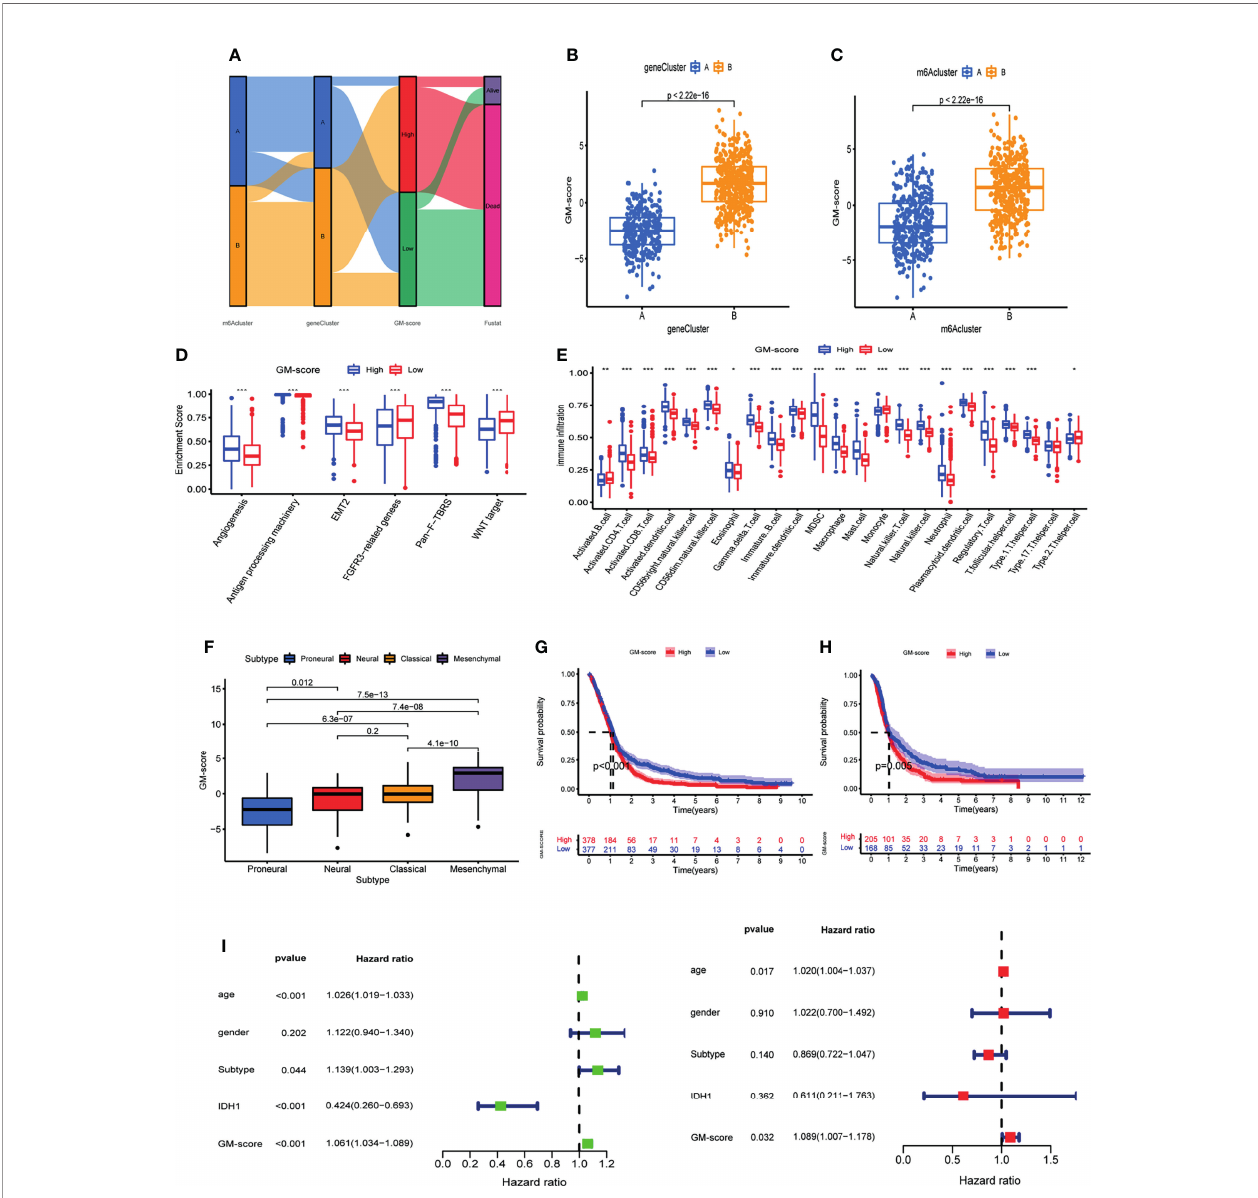
FIGURE 5 | Construction of glioblastoma m6A scoring system (GM-score). (A) Alluvial diagram of GBM patient m6A cluster, m6A gene-cluster, and GM-score. (B) GM-score of the two m6A gene clusters. (C) GM-score of the two m6A clusters. (D) Degree of enrichment of stromal activation pathways in 2 GM-score subgroups. (E) Immune cell abundance in the 2 GM-score subgroups. (F) Differences in GM-score between various GBM subtypes. (G) Kaplan-Meier OS analysis of 2 GM-score subgroups in meta_cohort. (H) Kaplan-Meier OS analysis of 2 GM-score subgroups in CGGA cohort. (I) Independent prognostic analysis of GM-score. *, **, and *** indicate p = < 0.05, < 0.01, and < 0.001,